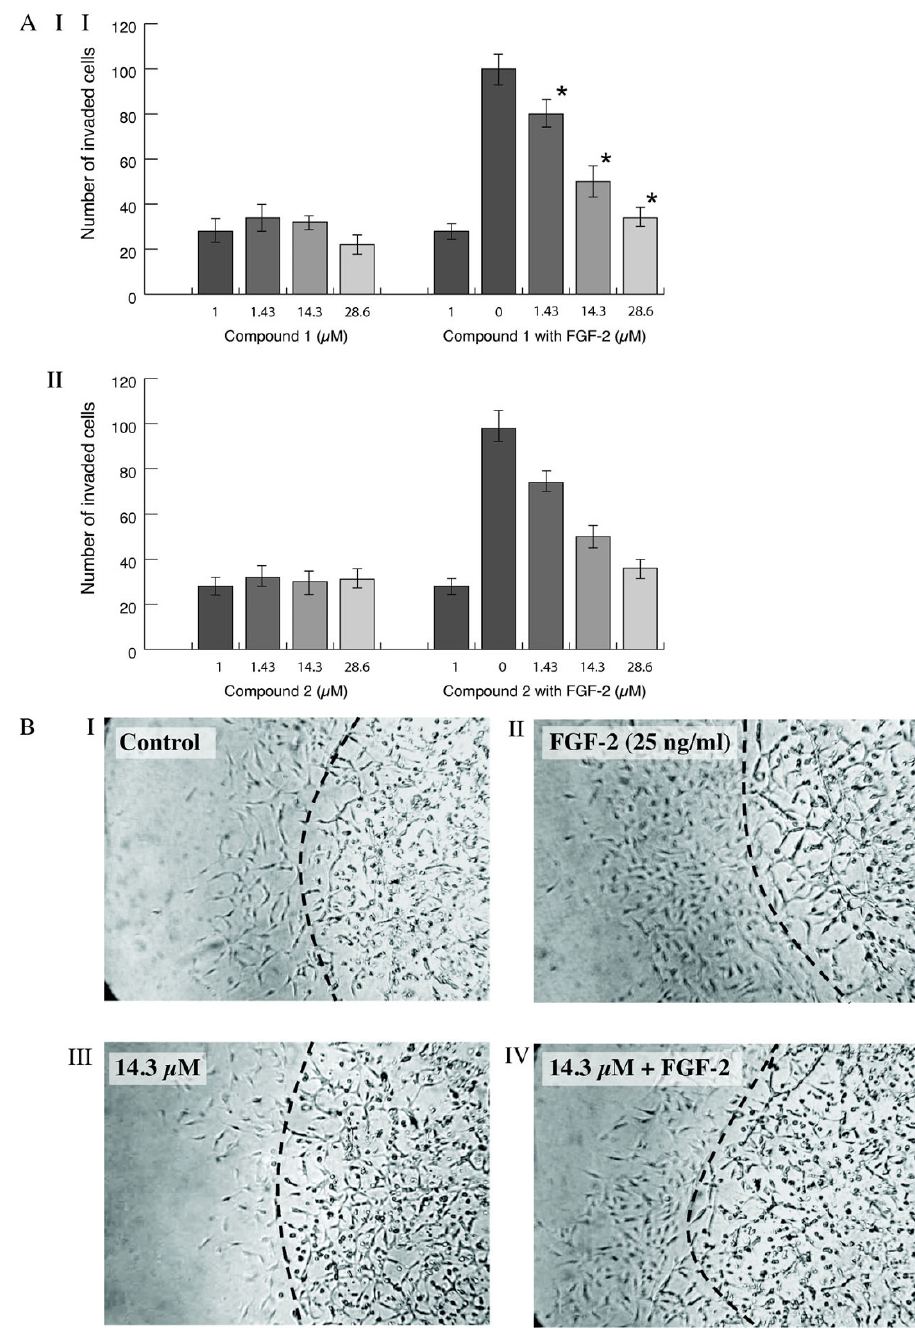
The effect of compounds 1 (AI) and 2 (AII) on BAEC invasion into a Matrigel layer was studied using the chemoinvasion assay described below . Cells (1.7 × 10 4 ) were added to the Matrigel coated upper Boyden chamber and the compounds with or without FGF-2 added to the lower chamber. Cell invasion was measured after 24 h and assessed as described below. Values significantly different (p < 0.05) from FGF-2 alone are shown by *. Results are the mean of three experiments. (B) Representative photomicrographs are shown for the effect of compound 1 on BAEC (original magnification × 20). Increased migration was seen with FGF-2 (25 ng/ml; panel II) and this was reduced in the presence of compound 1 (panel